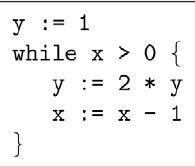
Figure 2. Pseudo-code to implement the exponentiation operation.